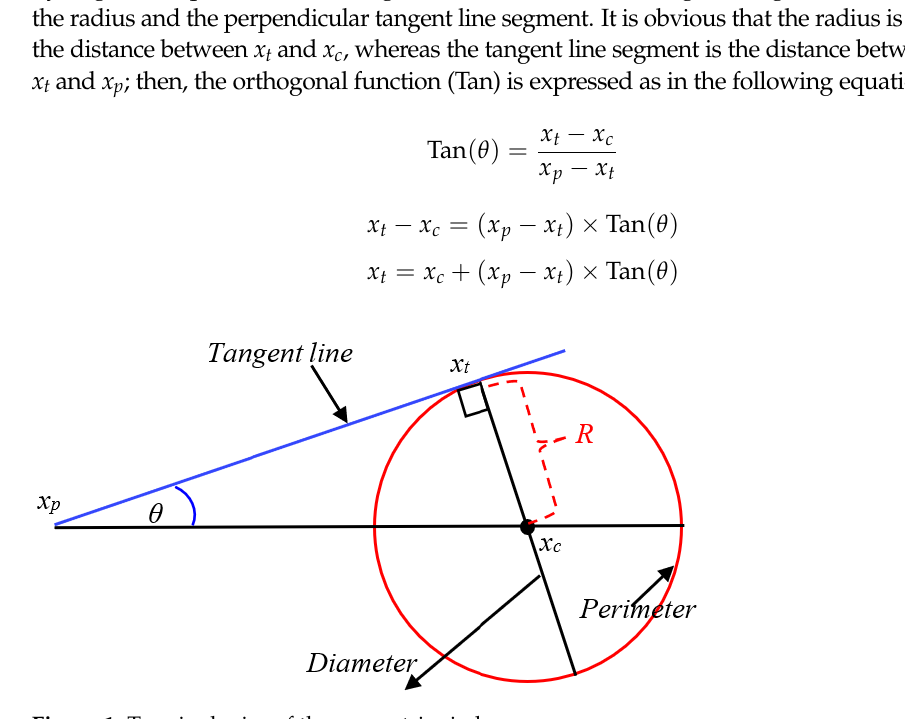
Figure 1. Terminologies of the geometric circle.